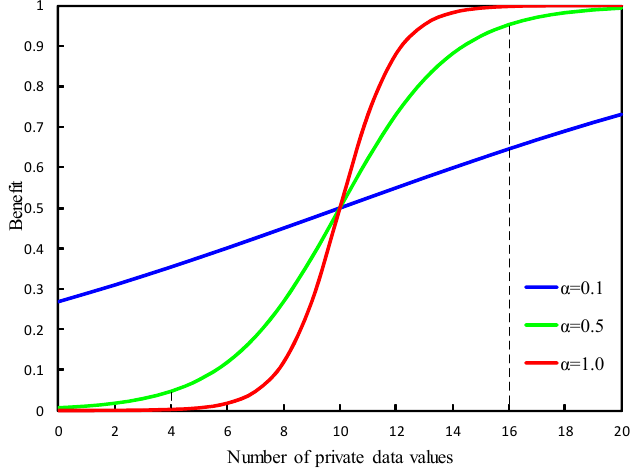
Figure 2. The correlation curves between the benefit and the number of private data values re- quired.